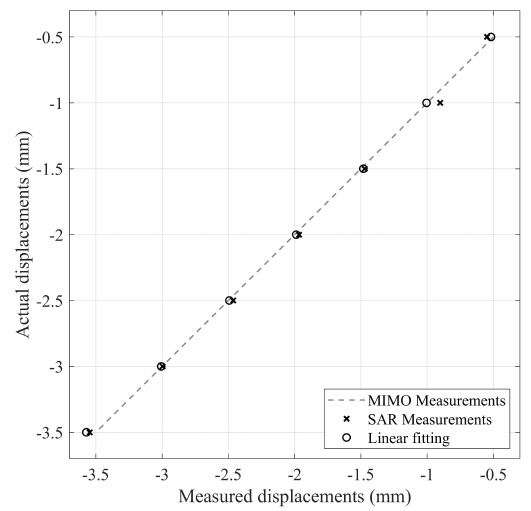
Figure 6. Comparison of MIMO radar and MIMO GBSAR displacement measurements with the reference values. We also evaluated and compared the results of MIMO radar and MIMO GBSAR configurations, using several metrics in Table 2. MIMO GBSAR obtained 0.06 radian angular resolution, which is much higher than MIMO radar’s 0.49 rad resolution.